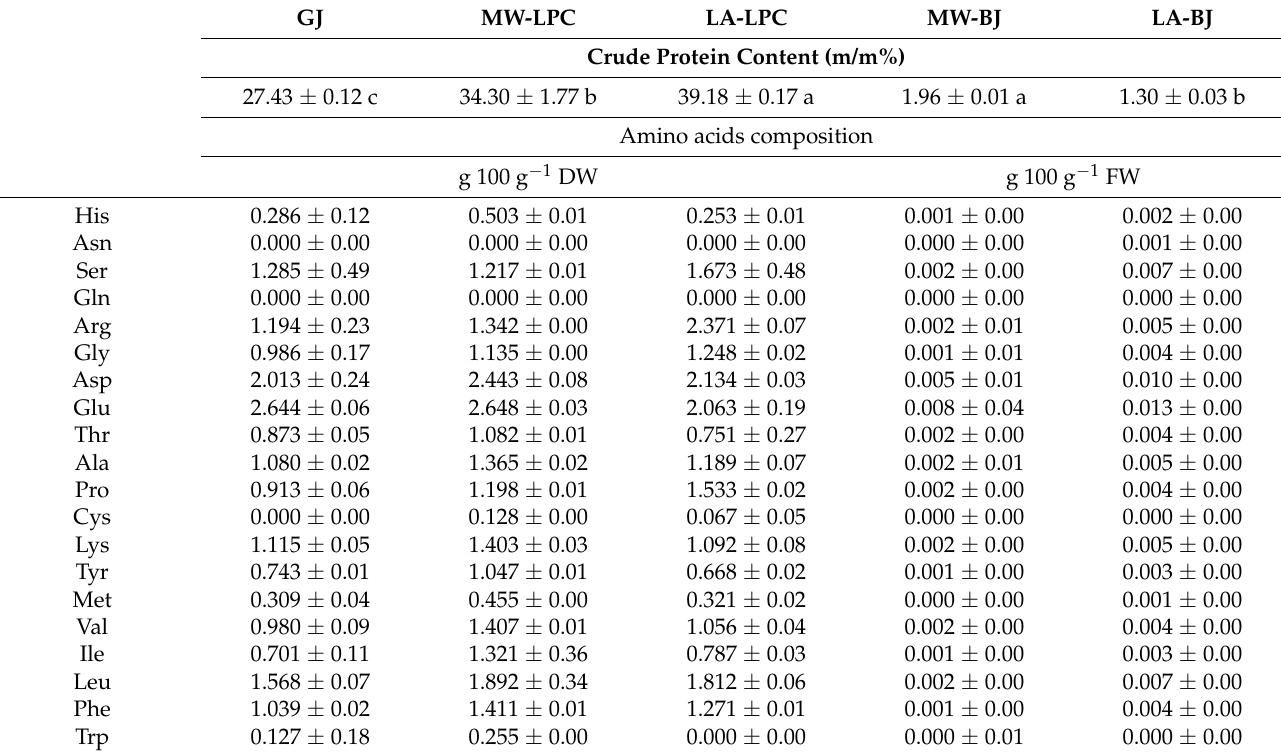
Table 1. Crude protein content and amino acid composition of broccoli green leaves-derived fractions by different processes ( Process 1; Process2 and Process 3 ): freeze-dried green juice (GJ); leaf protein concentrate obtained by microwave coagulation (MW-LPC); leaf protein concentrate obtained by lactic acid fermentation (LA-LPC); brown juice obtained by microwave coagulation (MW-BJ); and brown juice obtained by lacto-fermentation (LA-BJ). Data are means ± SD ( n = 2 (for amino acids) and 3 (for crude protein content)). One-way ANOVA performed for the crude protein content of all the fractions ( p ≤